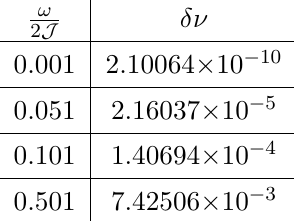
Table 1 . Difference in quantized values for ν from the exact and approximate methods as a function of ω 2 J